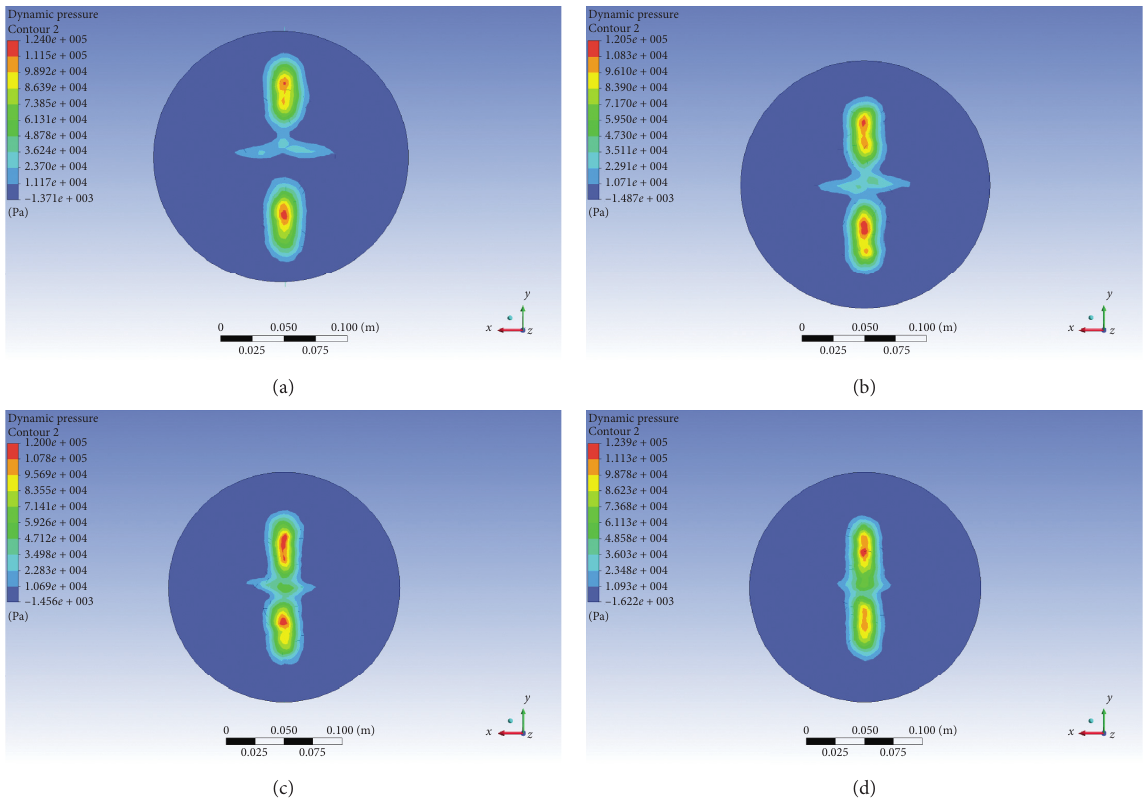
Figure 15: Dynamic pressure nephograms of target surfaces with different spacing. (a) 100mm. (b) 80mm. (c) 70mm. (d) 60 mm.